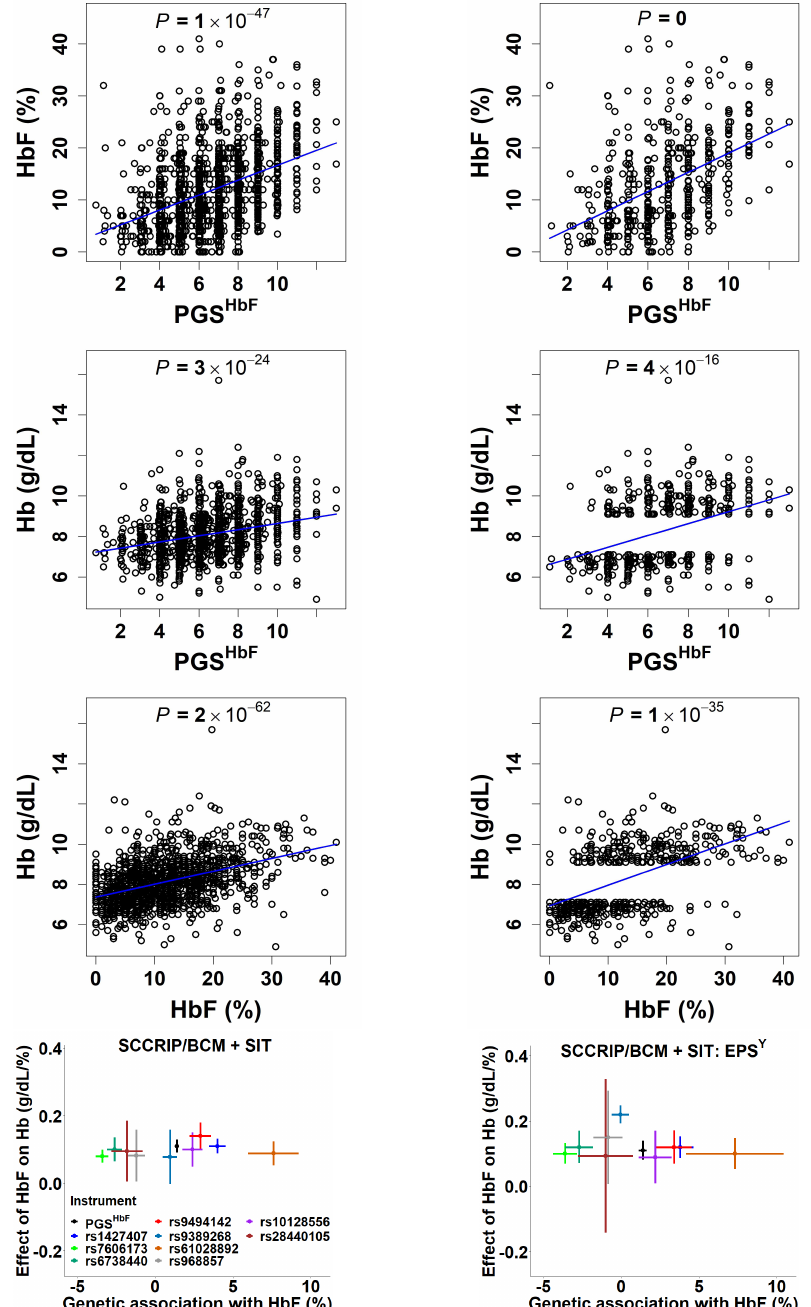
Figure 4. Top left and right panels: comparison between the effects of PGS HbF on HbF and Hb and correlation between HbF and Hb in SCCRIP/BCM and SIT combined cohort and EPS Y derived from SCCRIP/BCM and SIT combined cohort, respectively. The p value of the top right plot was calculated using STEPS [16], and the p values of the other plots were calculated using linear regression model, adjusting for covariates of cubic-spline–defined age, sex, sickle diagnosis (Yes/No), and top 5 PCs. Bottom panel: HbF induced by BCL 11 A and HBS 1 L − MYB causally influences Hb in SCCRIP/BCM and SIT combined ( left ) and EPS Y ( right ) patients. X-axis: Genetic association with HbF (%). Y-axis: (Causal) Effect of HbF on Hb (g/dL/%). SCCRIP/BMC = Sickle Cell Clinical Research Intervention Program study and Baylor College of Medicine; SIT = Silent Cerebral Infarct Transfusion